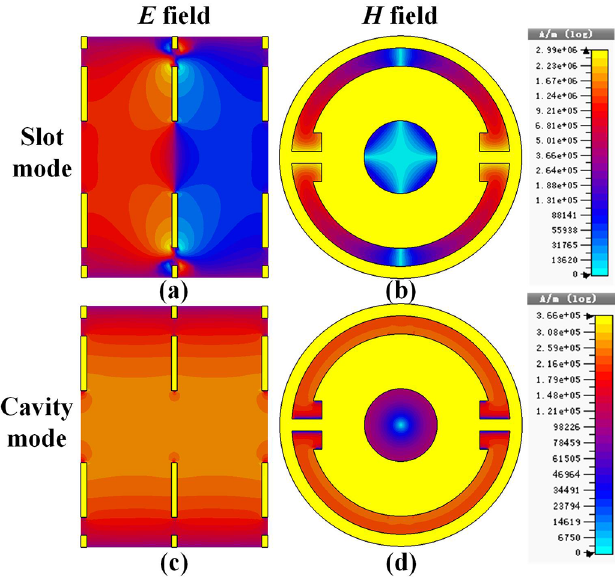
Fig. 2. Contours of the longitudinal electric fi eld and transverse magnetic fi eld. (a) Longitudinal electric fi eld of the slot mode and (b) transverse magnetic fi eld of the slot mode, (c) longitudinal electric fi eld of the cavity mode, and (d) transverse magnetic fi eld of the cavity mode